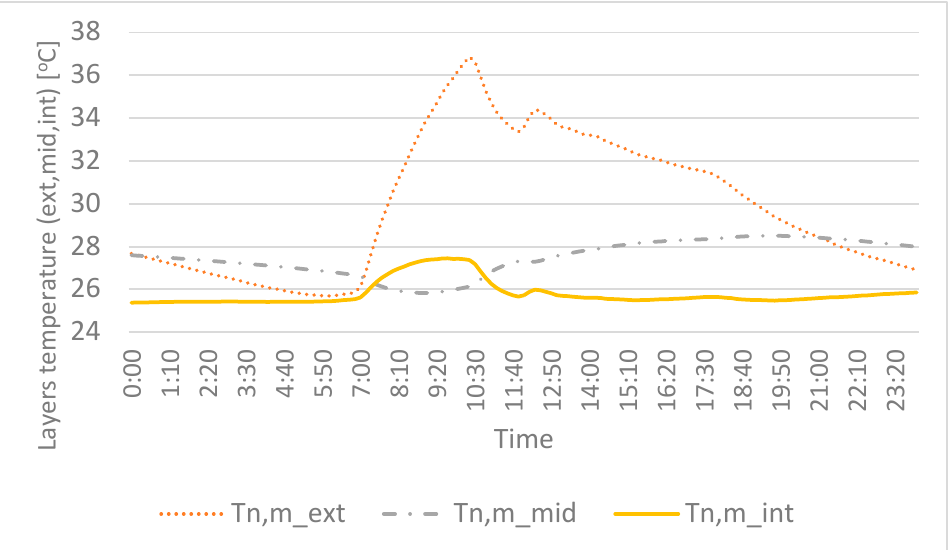
Figure 12. Graph of the average temperature in three layers of the wall on 5 January 2021. Figure 7 shows that the outdoor temperature variation was not greater than 3 °C during the whole week. 3.5. Heat Fluxes between Layers Four control surfaces were distinguished on the edges of the wall and between the layers. The heat flux through these surfaces can be calculated 𝑞 = 𝜆 Δ𝑥 (cid:3435)𝑇 (cid:3041),(cid:3036) − 𝑇 (cid:3041),(cid:3037) (cid:3439).